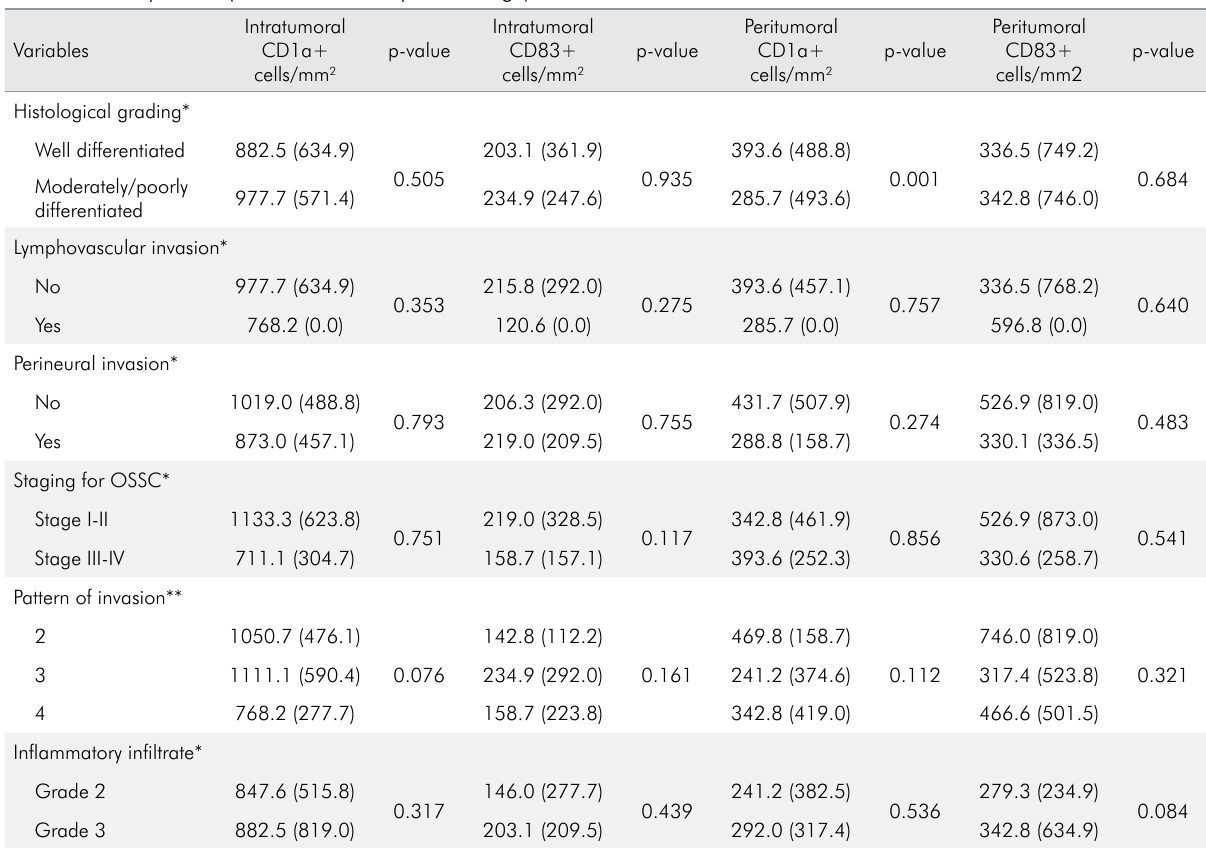
Table 3. Comparison between clinicopathologic findings and the number of intra and peritumoral dendritic cells in oral squamous cell carcinoma patients (median and interquartile